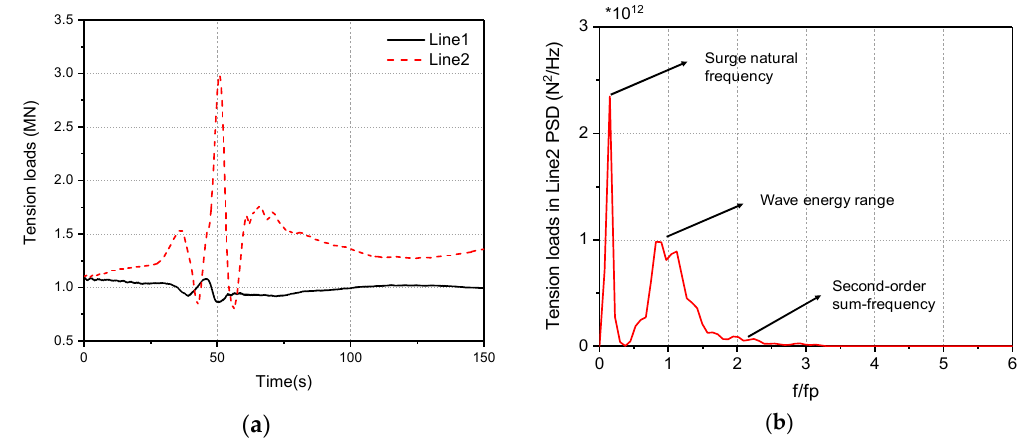
Figure 27. Tension loads of Line 1 and Line 2 and PSDs analysis for a parked wind turbine subject to focused wave: ( a ) tension loads of mooring lines; ( b ) PSDs of tension loads.